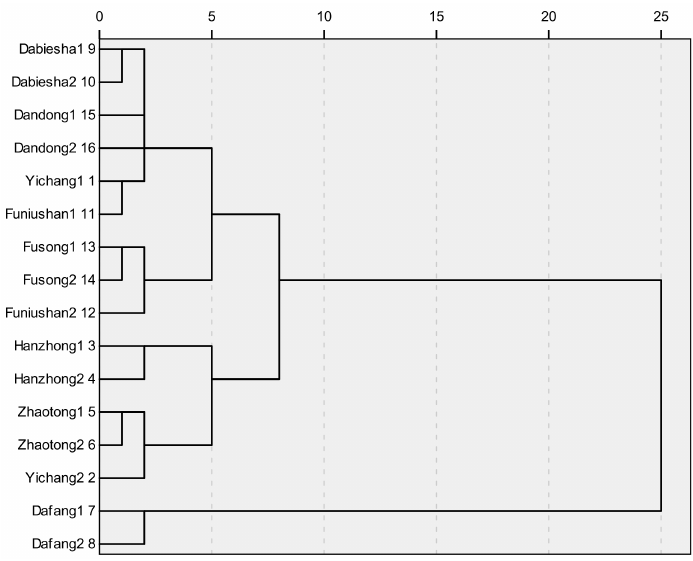
Figure 2. The clustering analysis of 16 batch G. elata